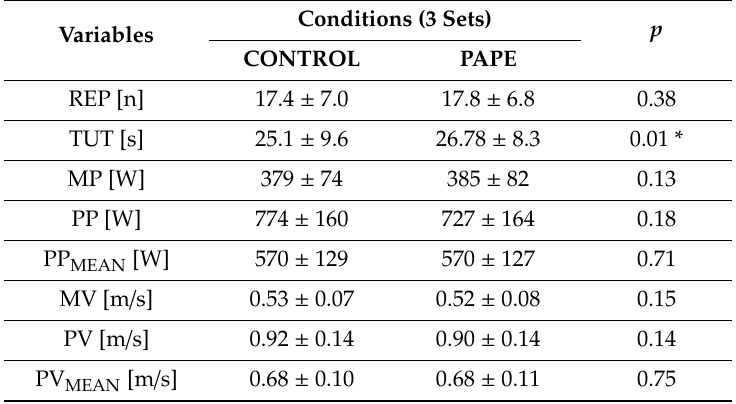
Table 1. Performance variables during 3 sets of the bench press exercise.